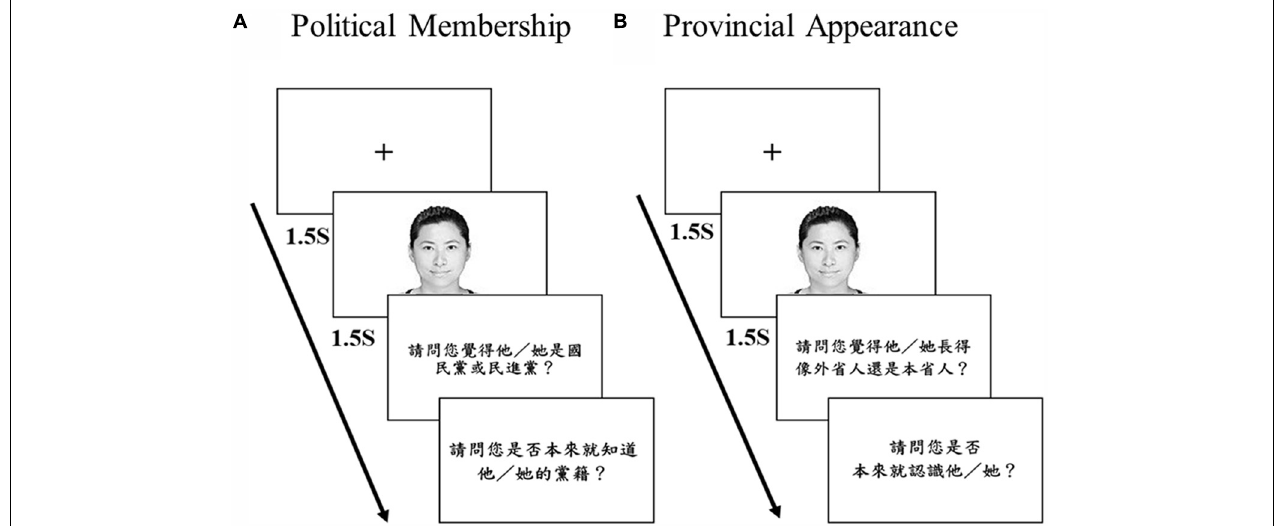
FIGURE 2 | The illustration of a sample trial in the political membership categorization task of Experiments 1 and 3 (A) , and a sample trial in the provincial appearance categorization task of Experiment 3 (B) . The translation of the first question in (A) is “Which political party do you think he/she belongs to, KMT or DPP?” and that of the second question is “Do you already know his/her political party?” The translation of the first question in (B) is “Which provincial group do you think he/she belongs to, Mainlander or Native Taiwanese?” and that of the second question is “Do you already know this